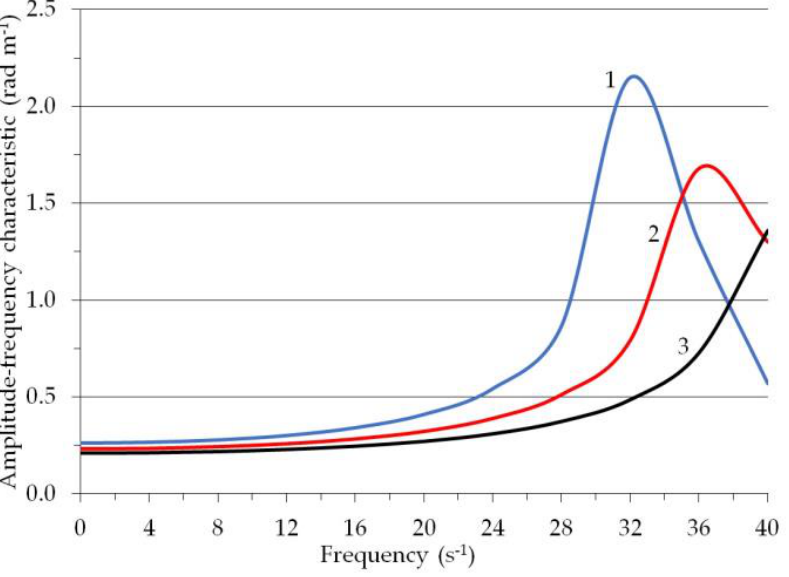
Figure 5. Amplitude–frequency characteristics of the dynamic system during the performance of the Figure 5. Amplitude – frequency characteristics of the dynamic system during the performance of disturbance at different values of the parameter L : curve 1, L = 3.8 m; curve 2, L = 4.3 m; curve 3, the disturbance at different values of the parameter 𝐿 : curve 1, L = 3.8 m; curve 2, L = 4.3 m; curve L = 4.8 3, L = 4.8 m